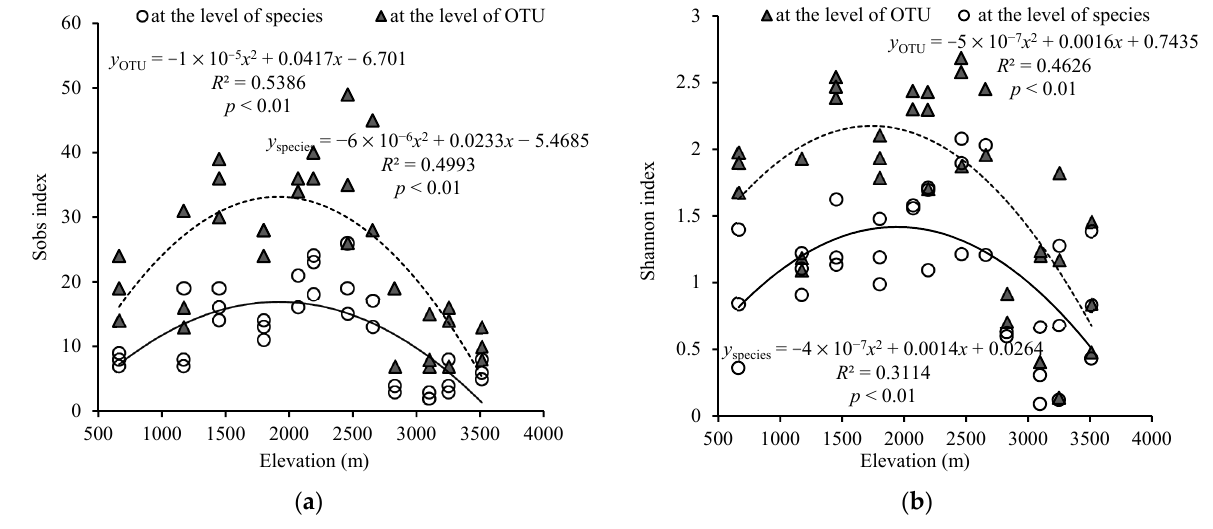
Figure 3. The variation of AMF is based on the species and OTU level among different elevations with the Sobs index of species ( a ) and the Shannon index of species ( b ).